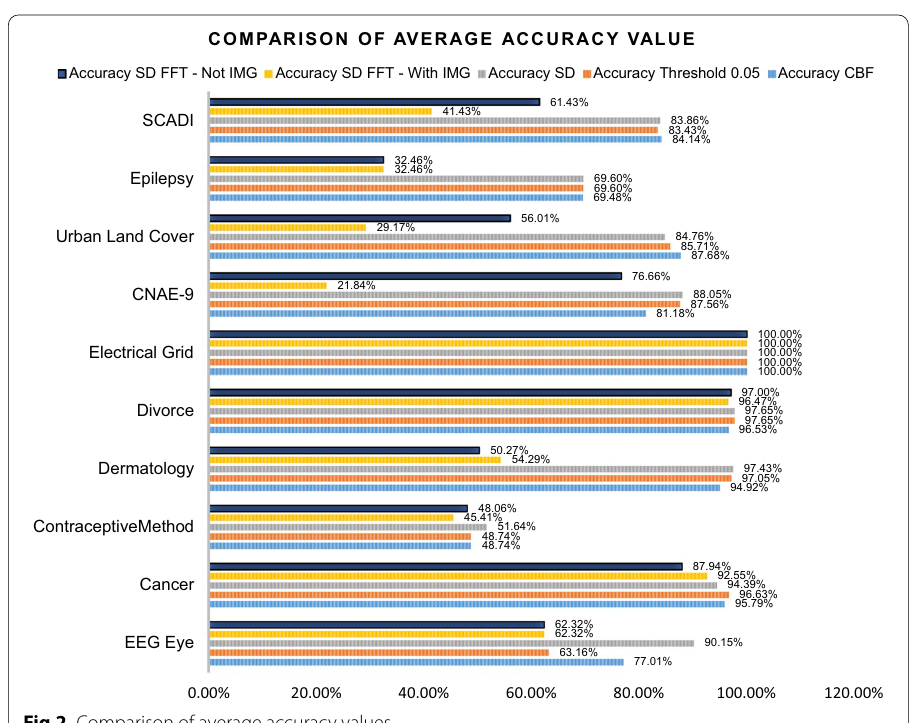
Fig.2 Comparison of average accuracy